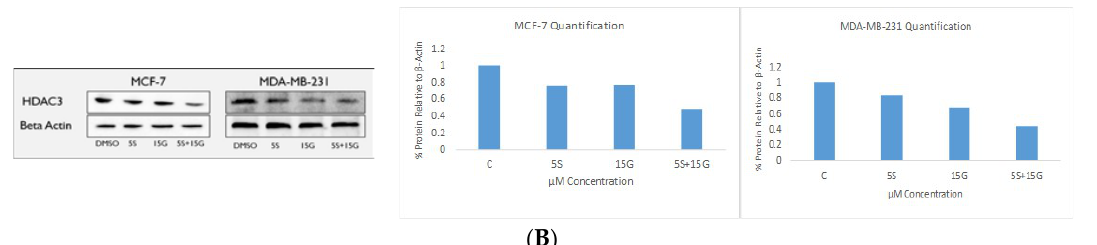
Figure 10. Western Blot. HDAC2 and HDAC3 protein levels are downregulated by GEN and SFN in breast cancer cells. ( A ) combinatorial GEN and SFN downregulates HDAC2 in MCF-7 and MDA-MB-231 breast cancer cells with the combination appearing to be the most effective. Results of densitometry analyses of the aforementioned western blots using ImageJ software; ( B ) combinatorial GEN and SFN downregulates HDAC3 expression in MCF-7 and MDA-MB-231 breast cancer cells with the combination appearing to be the most effective. Results of densitometry analyses of the aforementioned Western blots using ImageJ software. The figures are representative of similarly performed experiments ( n = 3). The densitometry analysis was done of the representative figure.